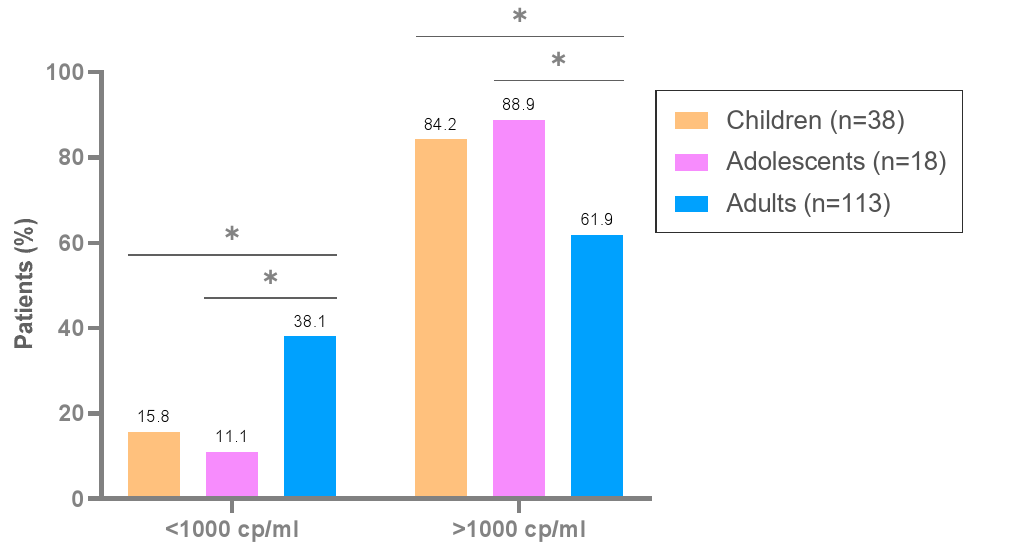
Figure 1. Therapeutic failure in the 169 HIV-infected and treated subjects of EG (2019–2020). Treated, ART-treated; cp/mL, copies of HIV-1 RNA per plasma milliliter; therapeutic failure, >1000 cp/mL; *, significant P values <0.05.